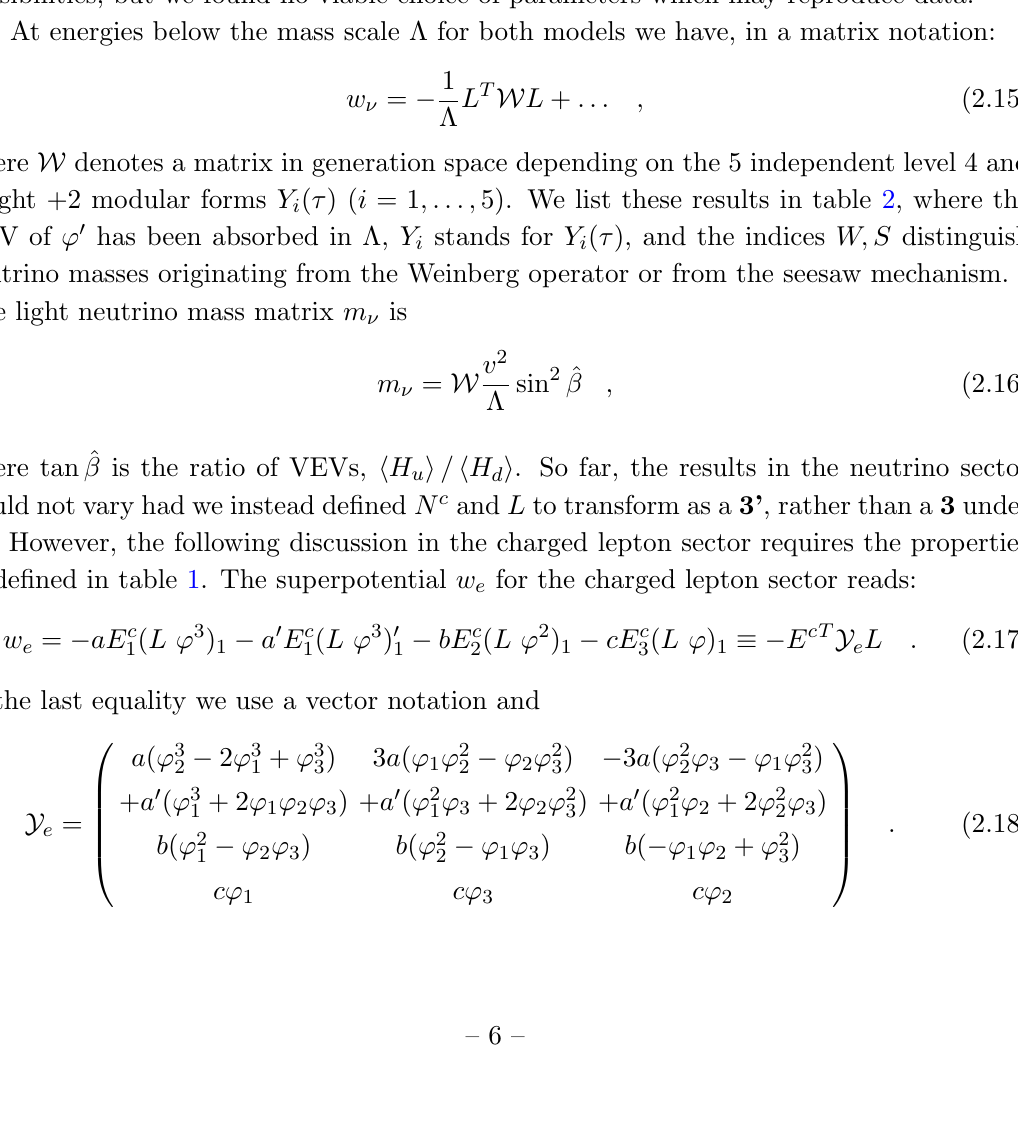
denotes the r r